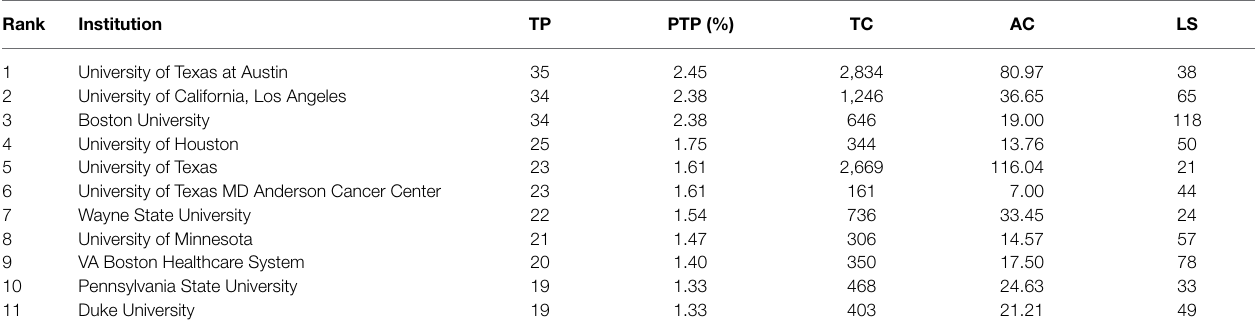
TABLE 3 | The top 11 most contributive